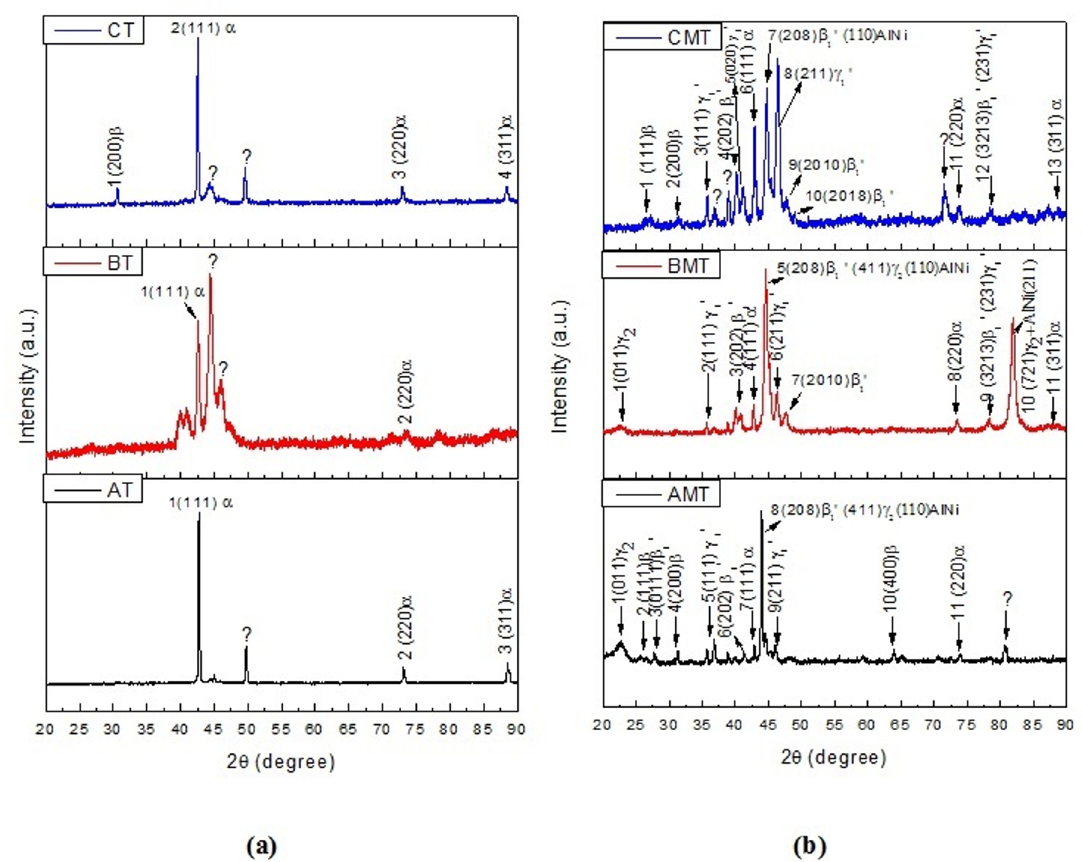
Figure 6. X-ray diffractograms of the studied Cu-Al-Ni alloys. (a) Quenched bronzes (as provided). (b) Modified and quenched Cu-Al- Ni alloys. Table 5. Chemical composition (%wt.) obtained by EDS for the modified and quenched aluminum bronzes. Cu-Al-Ni ↓